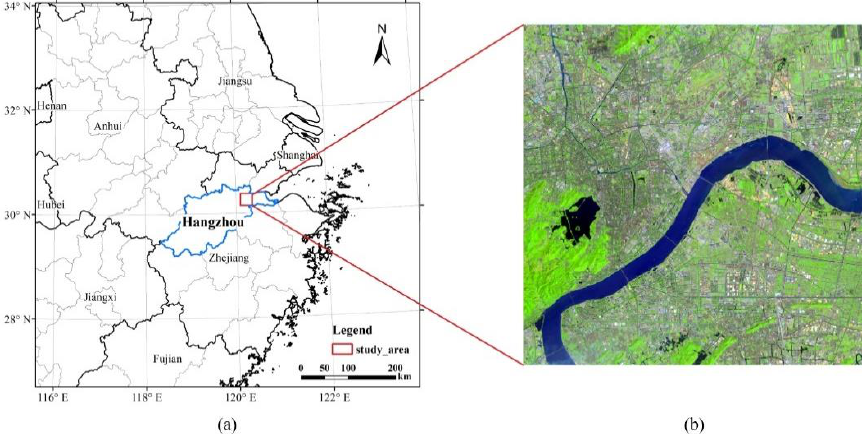
Figure 5. Study area ( a ) Location of the study area in the Yangtze River Delta; ( b ) Landsat 8 composite of the study area.